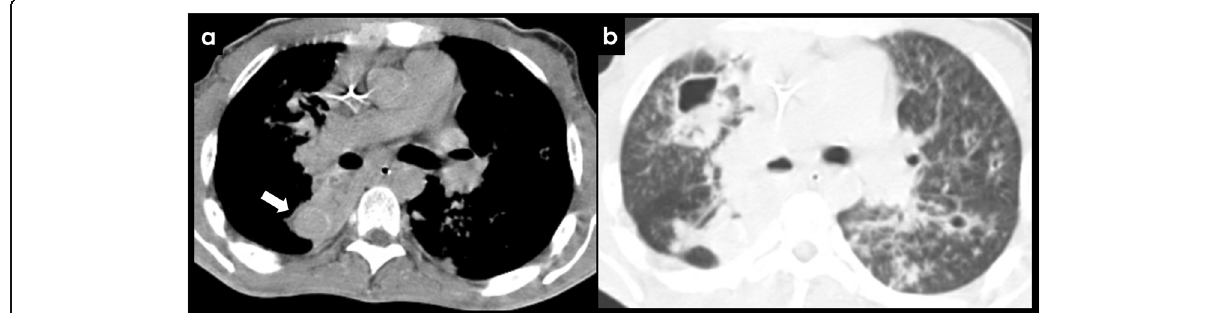
Fig. 8 Rasmussen ’ s aneurysm. Active TB can cause hemoptysis due to rupture of a Rasmussen ’ s aneurysm ( a , white arrow), which is a pseudo- aneurysm of the pulmonary artery adjacent to a cavity in patients with pulmonary TB ( b